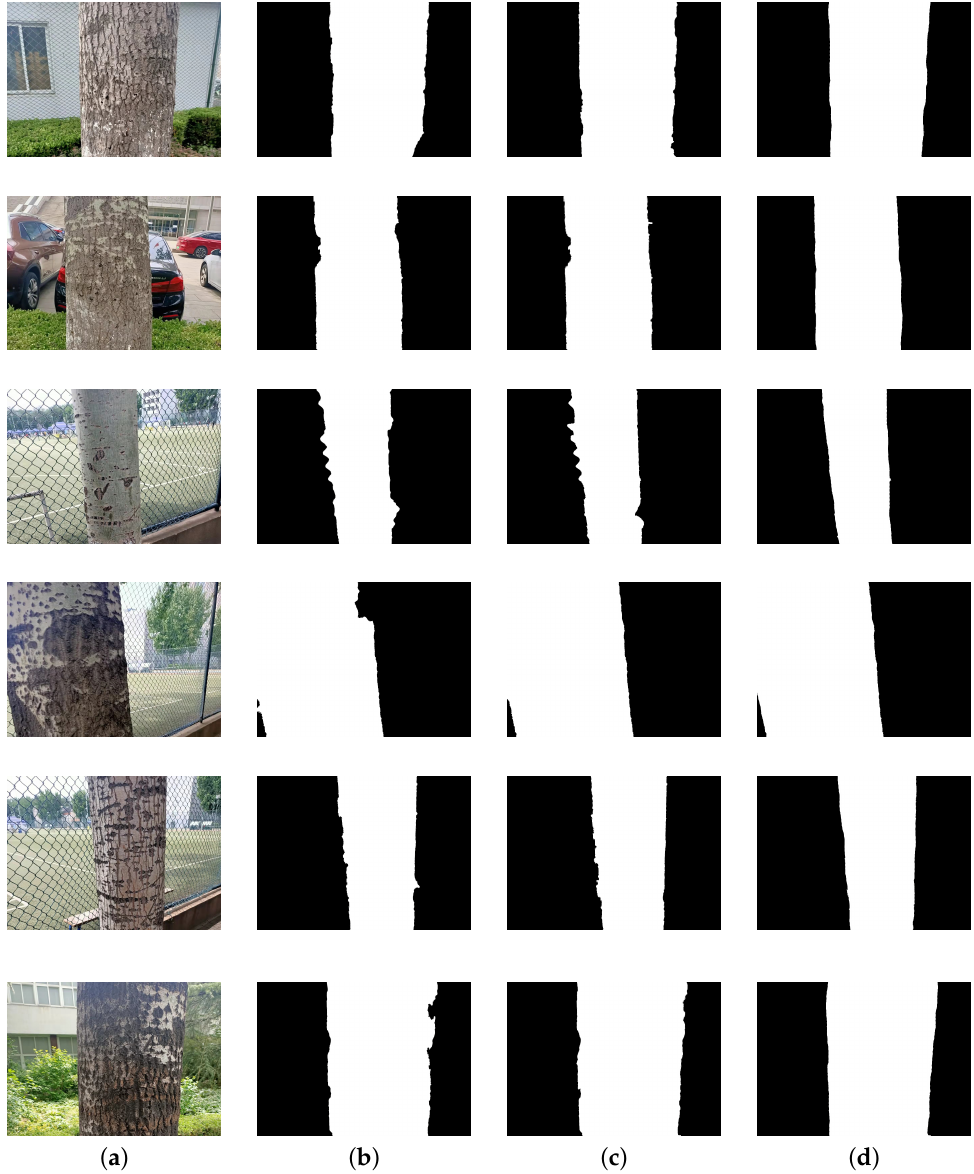
Figure 20. Segmentation results of long jujubes. ( a ) Original image. ( b ) Maximum entropy. ( c ) Pro- posed marker-controlled watershed algorithm. ( d ) Artificial